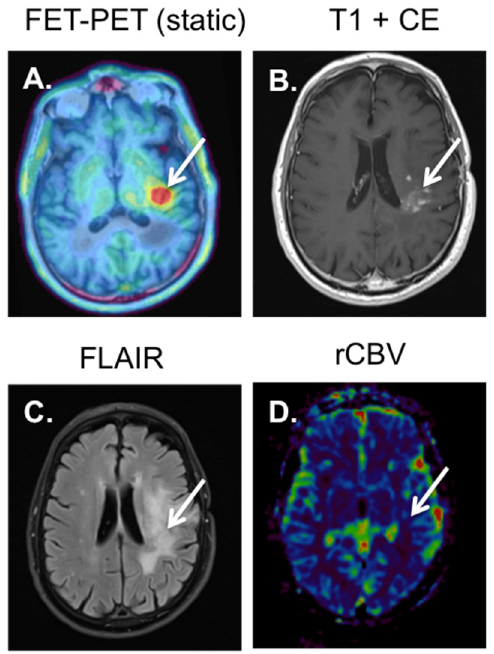
Figure 2. Patient with an astrocytoma grade III, IDHwt that was treated with radiotherapy and temozolomide. Five months after treatment, persisting contrast enhancement is visible in the left parietal lobe (white arrow ( B )), with accompanying gliotic changes on FLAIR (white arrow ( C )), without an increase in perfusion. See relative rCBV map (white arrow ( D )). The 18 F ‐ FET ‐ PET ( A ) shows an increased tracer accumulation in the area of contrast enhancement with a TBR max of 2.5 (>2.0), indicating progressive disease (see white arrow ( A )).